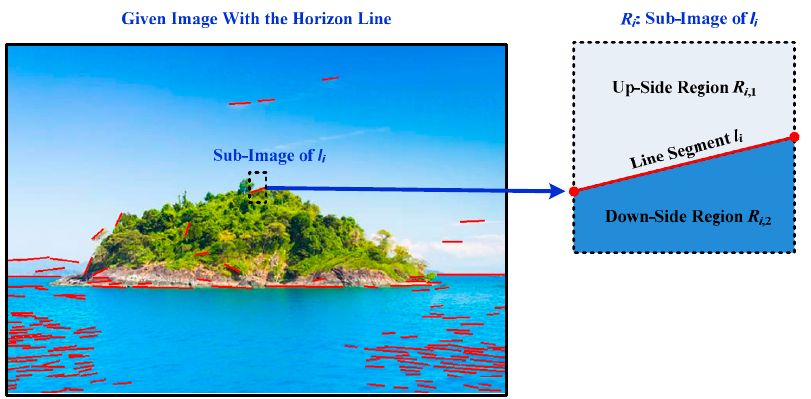
Figure 4. The color feature of the horizon line segments: ( a ) The image examples contain the horizon line with blue sea and white/blue sky; ( b ) The image examples contain the horizon line with blue sea, white/blue sky and other objects, such as boat, bird, and island; ( c ) The image examples contain the horizon line with the setting sun scene.